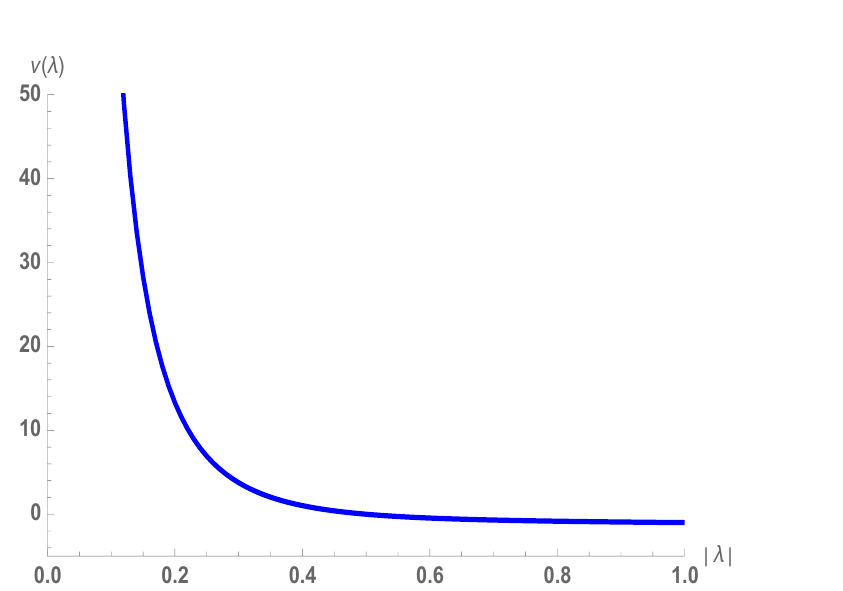
Figure 28. Numerically determined (cid:12)rst order transition lines with m F sgn( (cid:21) ) = 1 for di(cid:11)erent values of j (cid:21) j .